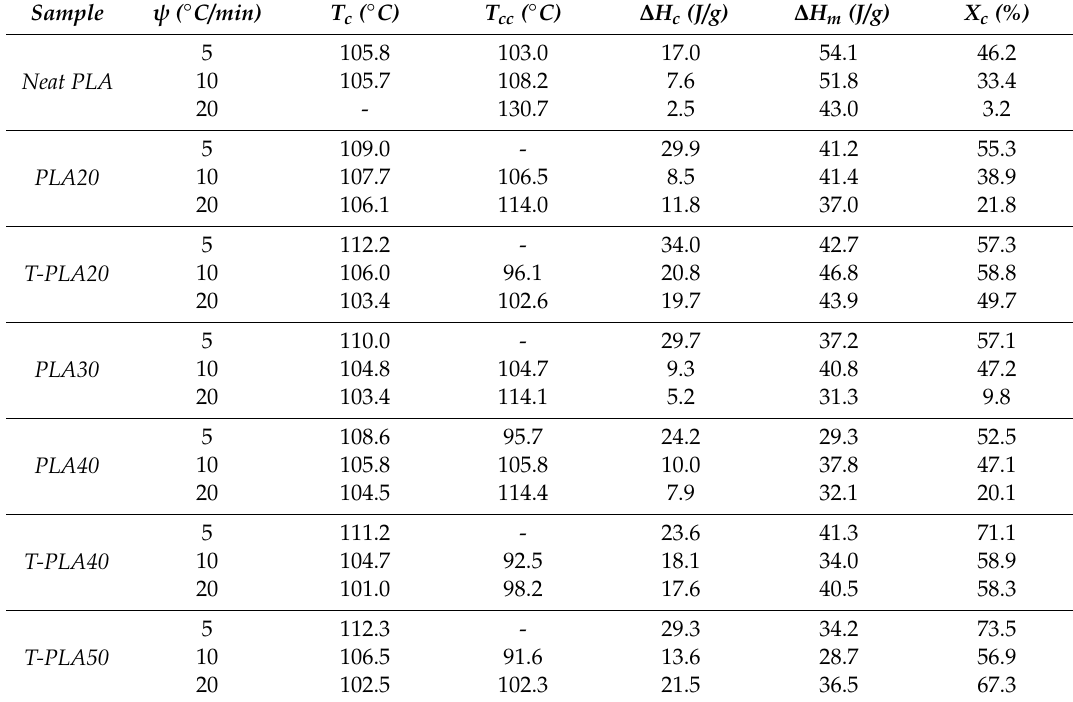
Table 2. Melting and crystallization properties of the neat PLA and its hybrid